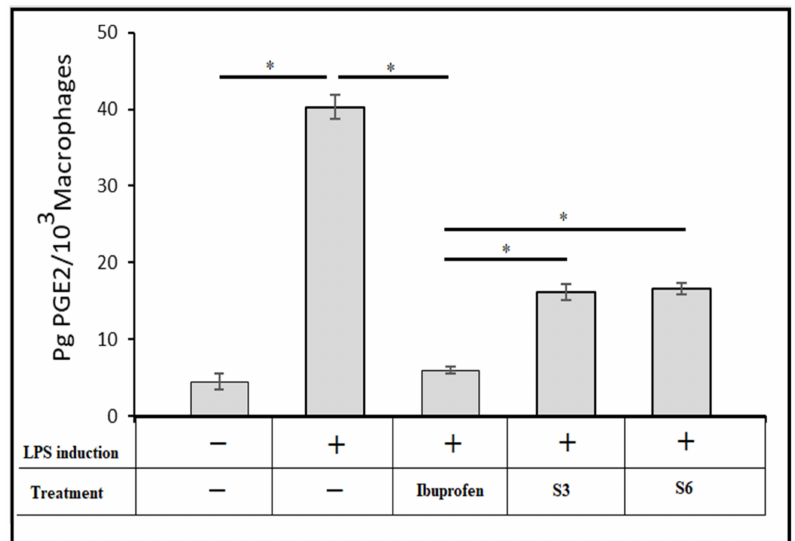
Figure 9. The effect of optimised IBU nanoconjugate hydrogels S3 and S6 on the production of prostaglandin E2 in RAW264.7 cells induced by LPS, where + indicates LPS induction was used to treat the cells,—indicates LPS was not used to treat the cells, and * indicates a p -value <0.05 for one-way ANOVA with Tukey’s post hoc